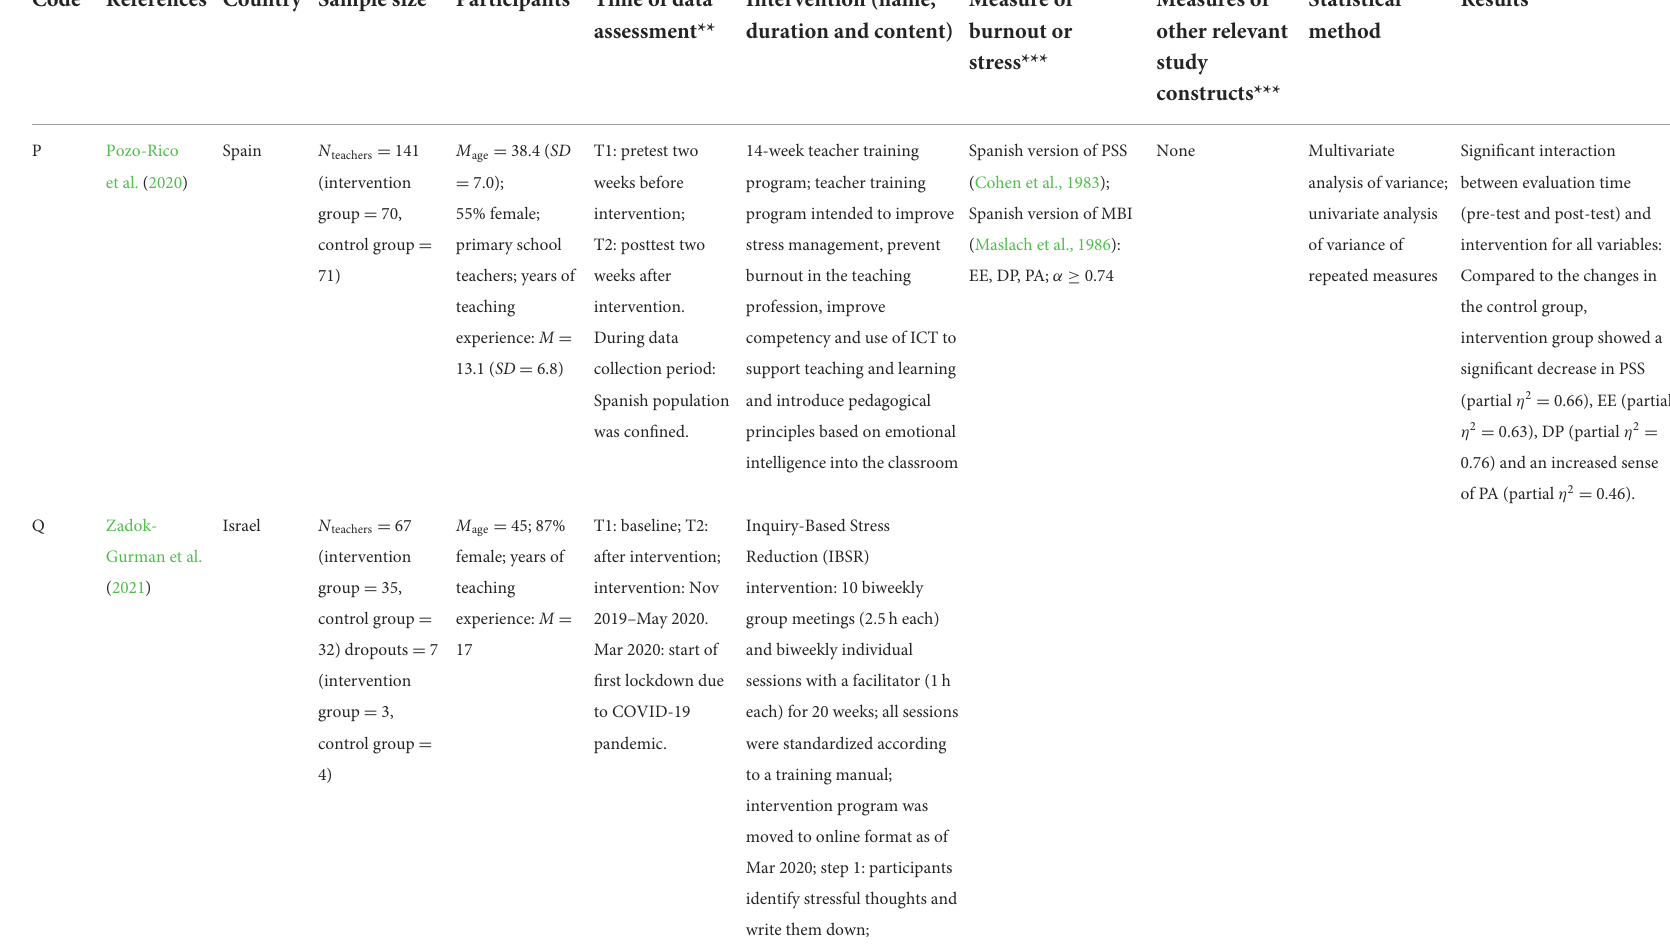
TABLE 2 Description of intervention studies included in the